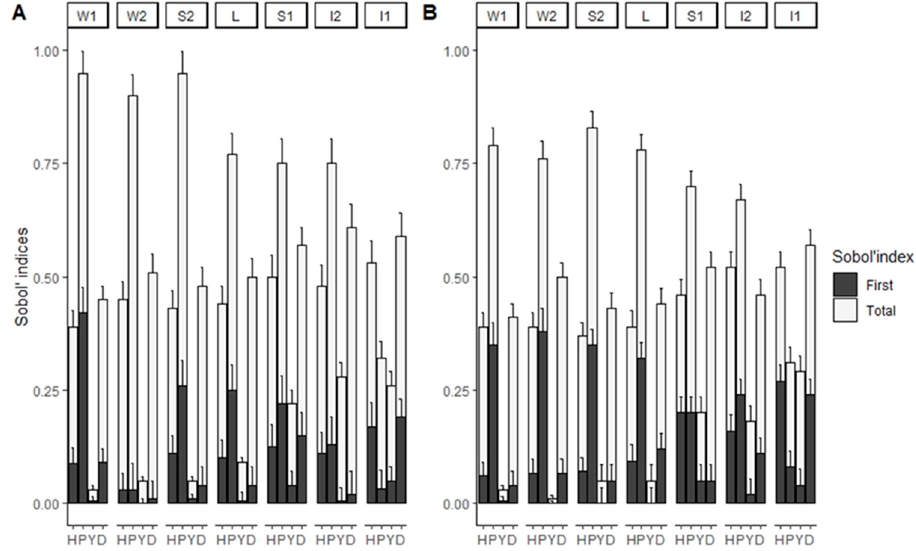
Figure 5. Sobol’s indices: first index (dark grey) and total index (light grey) for each factor (the hatching rate (H), probability that the water balance is positive (P), mean number of resting eggs produced per female (Y) and deterioration rate (D) and each clone (W1, W2, S2, L, I2, S1, I1) in 2 climatic conditions: present ( panel A ) and climate change ( panel B ). The error bar represent the standard error estimated from the bootstrap procedure (n = 1000).